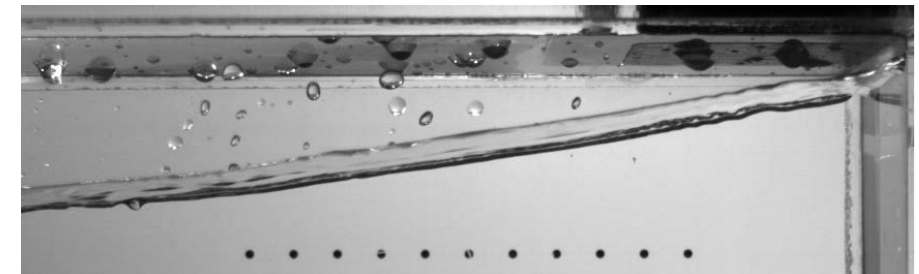
Figure 24. Droplet Location of SWAY (the 2 nd experiment).